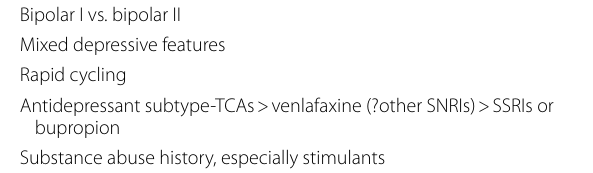
Table 1 Risk factors for treatment emergent affective